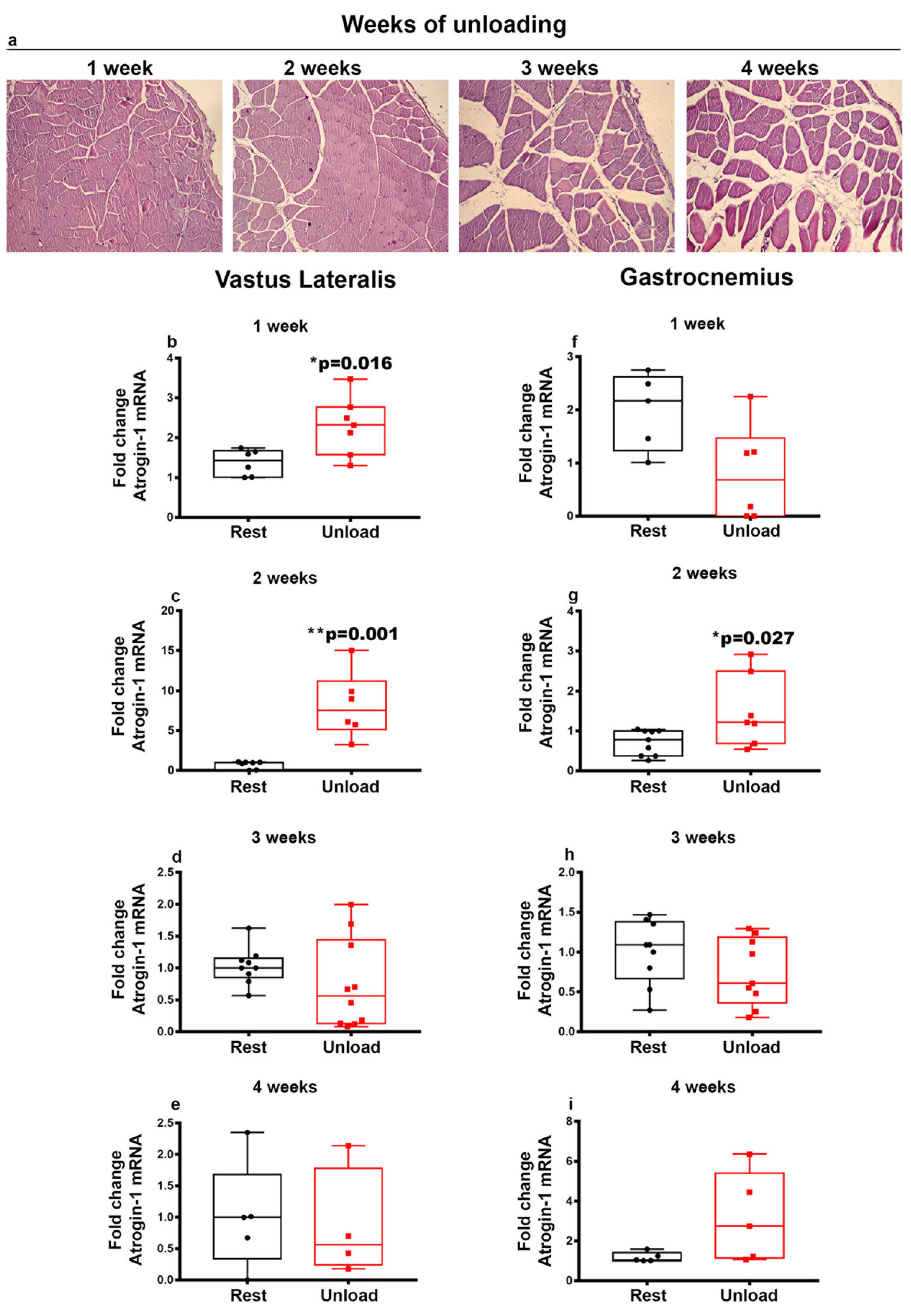
Fig. 1 Effect of unloading on muscle morphology and Atrogin-1 mRNA expression in Vastus Lateralis and Gastrocnemius. Haematoxylin and eosin (H&E) staining on transverse sections of Vastus Lateralis from HU mice for 1-,2-,3- and 4-weeks showing time-dependent increasing extent of fi brotic area and reduction in muscle fi ber diameters ( a ). Quantitative PCR (qPCR) showing mRNA expression levels of Atrogin-1 in Vastus Lateralis ( b – e ), and Gastrocnemius ( f – i ) muscles of control mice kept in resting condition (Rest) and HU mice (Unload) at time points 1- 2-3 and 4 weeks. The results showed a signi fi cant increase in Atrogin-1 expression at 1 and 2 weeks in Vastus Lateralis ( b , c ) and at 2 weeks in Gastrocnemius ( g ) muscles. Shapiro-Wilk test and Mann-Whitney test were performed. Data are presented as box-and-whisker with median and interquartile ranges, from max to min, with all data points shown. * p < 0.05, ** p < 0.01 vs